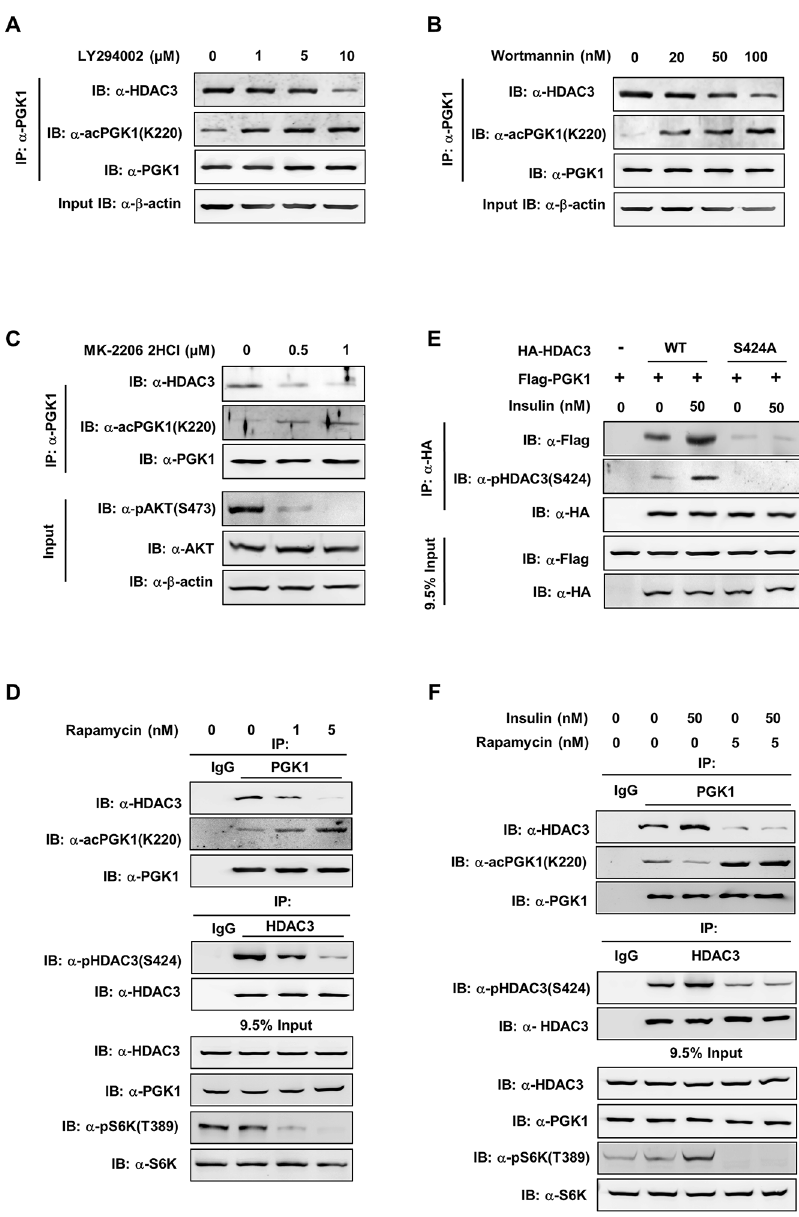
Fig 6. The mTOR pathway regulates HDAC3 S424 phosphorylation and PGK1 K220 acetylation. ( A, B ) Inhibition of PI3K increases the K220 acetylation level of endogenous PGK1. HEK293T cells were treated with two PI3K inhibitors, LY294002 (A) and Wortmannin (B), at the indicated concentrations for 4 hr and 2 hr, respectively. PGK1 protein was purified by IP with PGK1 antibody, following western blot to detect the K220 acetylation level of endogenous PGK1 and its interacting endogenous HDAC3. ( C ) Inhibition of AKT increases the K220 acetylation level of endogenous PGK1. HEK293T cells were treated with MK-2206 2HCI (a specific AKT inhibitor) at the indicated concentrations for 2 hr. PGK1 protein was purified by IP with PGK1 antibody, following western blot to detect the K220 acetylation level of endogenous PGK1 and its interacting endogenous HDAC3. AKT protein and AKT S473 phosphorylation levels were detected with anti-AKT antibody as well as anti-pAKT(S473) antibody. ( D ) Inhibition of mTOR decreases HDAC3 Ser424 phosphorylation and increases PGK1 K220 acetylation. HEK293T cells were treated with Rapamycin for 2 hr. Endogenous HDAC3 and PGK1 were immunopurified with HDAC3 and PGK1 antibodies, respectively, followed by western blotting to detect HDAC3 Ser424 phosphorylation and PGK1 K220 acetylation. S6K protein and S6K T389 phosphorylation levels were detected with anti-S6K antibody as well as anti-pS6K (T389) antibody. The phrase “ 9.5% input ” refers to the fact that 9.5% of total proteins for IP experiments